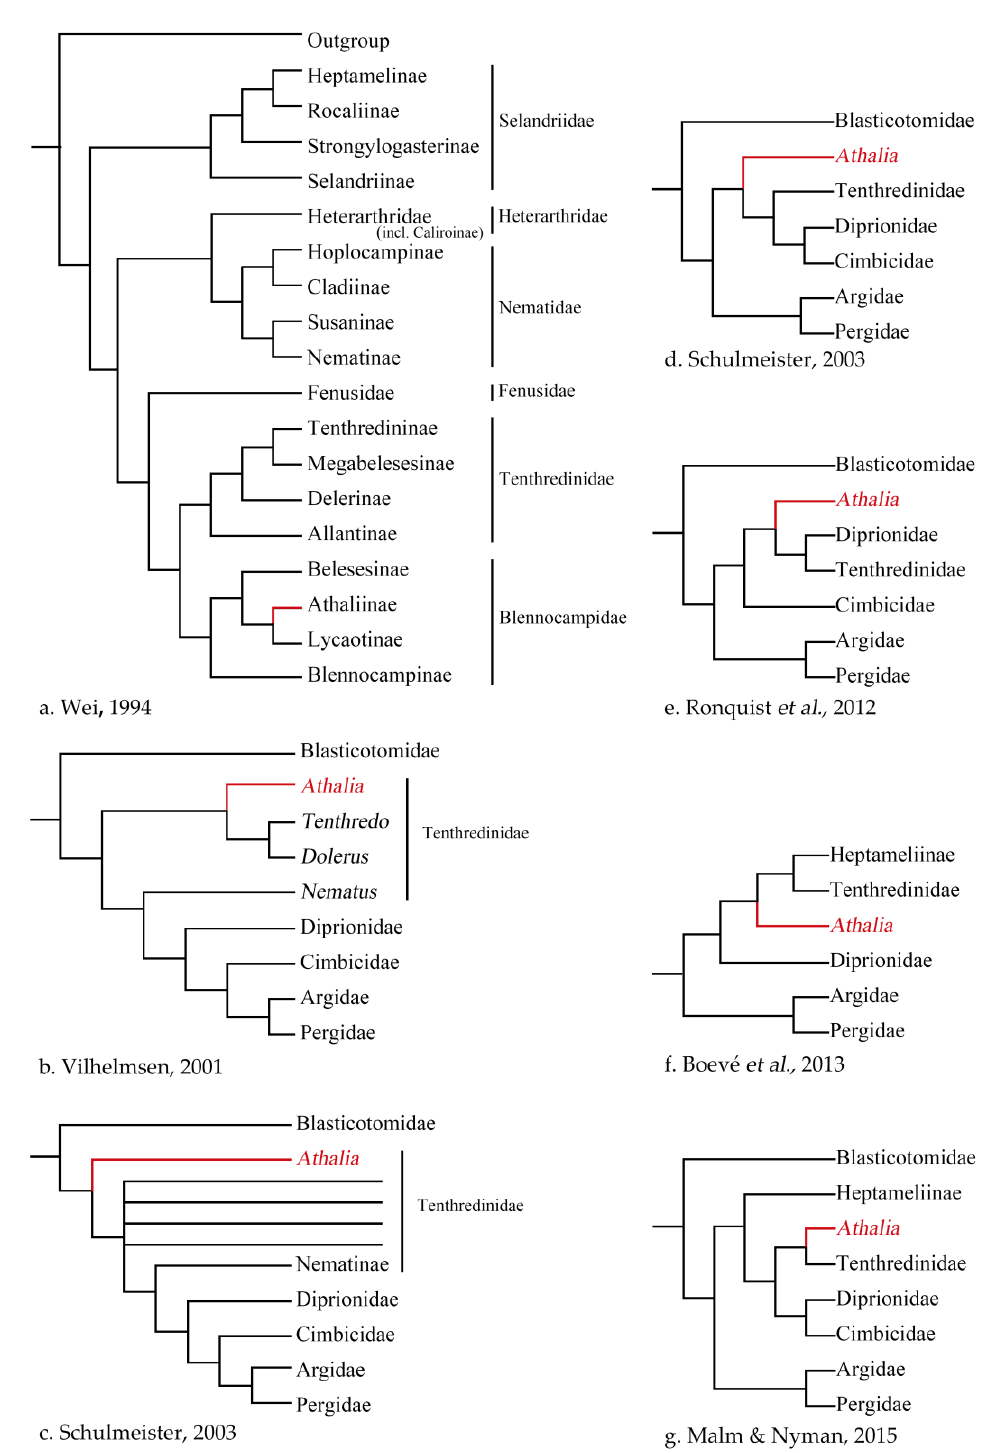
Figure 1. Schematic phylogeny for basal hymenopteran lineages simplified from the reference provided below each cladogram. ( a ) Wei, 1994 [28], Figure 5-1, morphological data; ( b ) Vilhelmsen, 2001 [29], Figure 11, morphological data; ( c ) Schulmeister, 2003 [30], Figure 7, morphological data; ( d ) Schulmeister, 2003 [31], Figure 3, morphological and molecular data; ( e ) Ronquist et al., 2012 [32], Figure 3, morphological and molecular data; ( f ) Malm and Nyman, 2015 [33], Figure 4, molecular data; ( g ) Boevé et al. 2013 [34], Figure 3, molecular data.